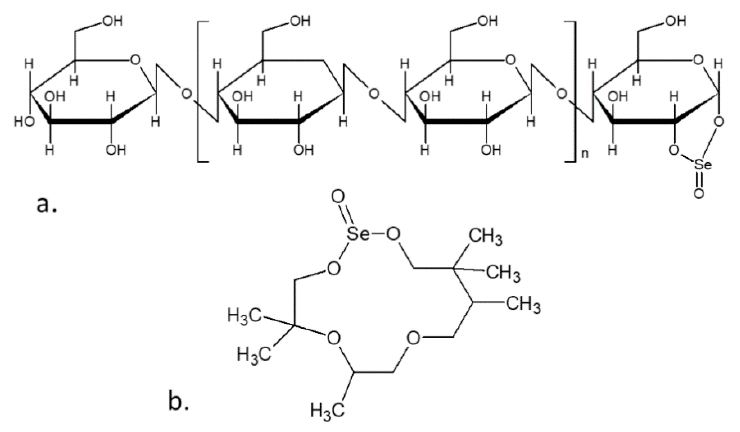
Figure 11. The proposed linear ( a ) and cyclic ( b ) structures of selenodextran (according to Huang et al. [345]) .